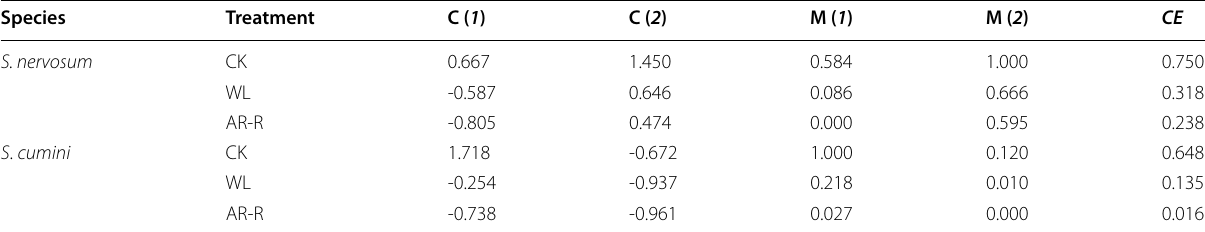
Table 3 Eigenvalue, membership function value, and comprehensive evaluation value in S. nervosum and S . cumini saplings under different